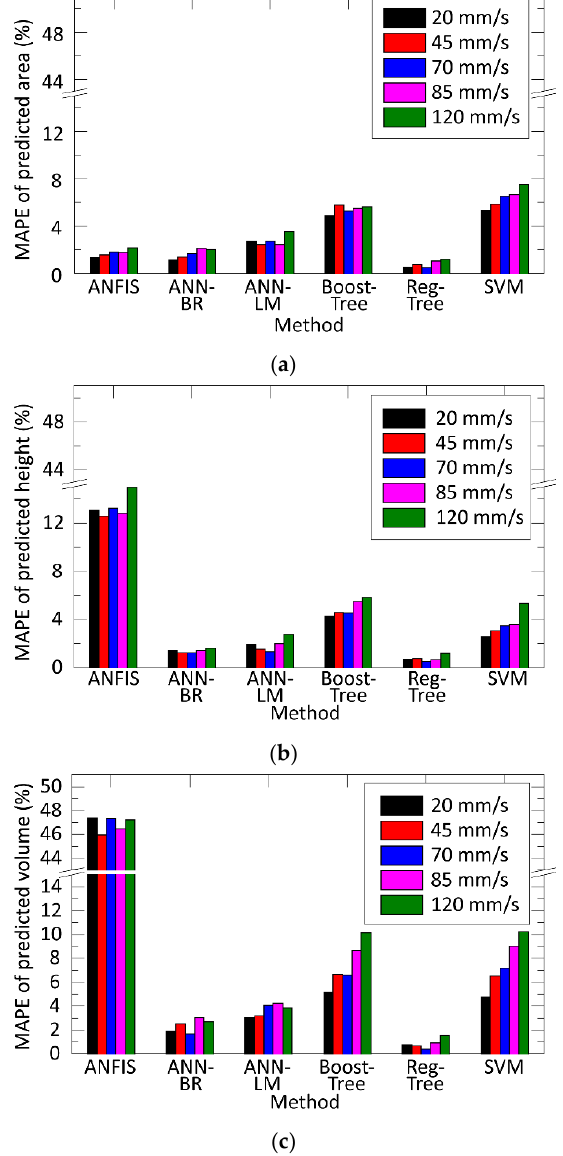
Figure 9. Comparing the prediction error as a function of printing speed: ( a ) error for the printed height; ( b ) error for the printed area; ( c ) error for the deposited paste volume.